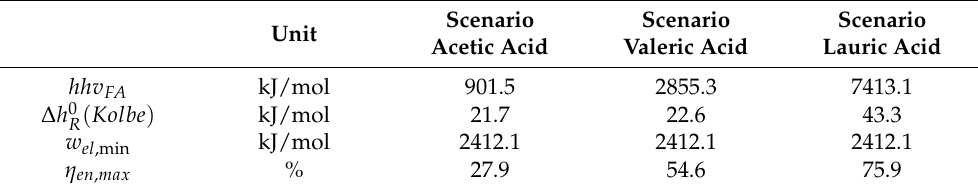
Table A3. Molar higher heating value of the FAs hhv FA , the reaction enthalpy of the Kolbe process ∆ h 0 ( Kolbe ) , the minimum electric work and the maximum theoretical energetic efficiency of the R three scenarios.